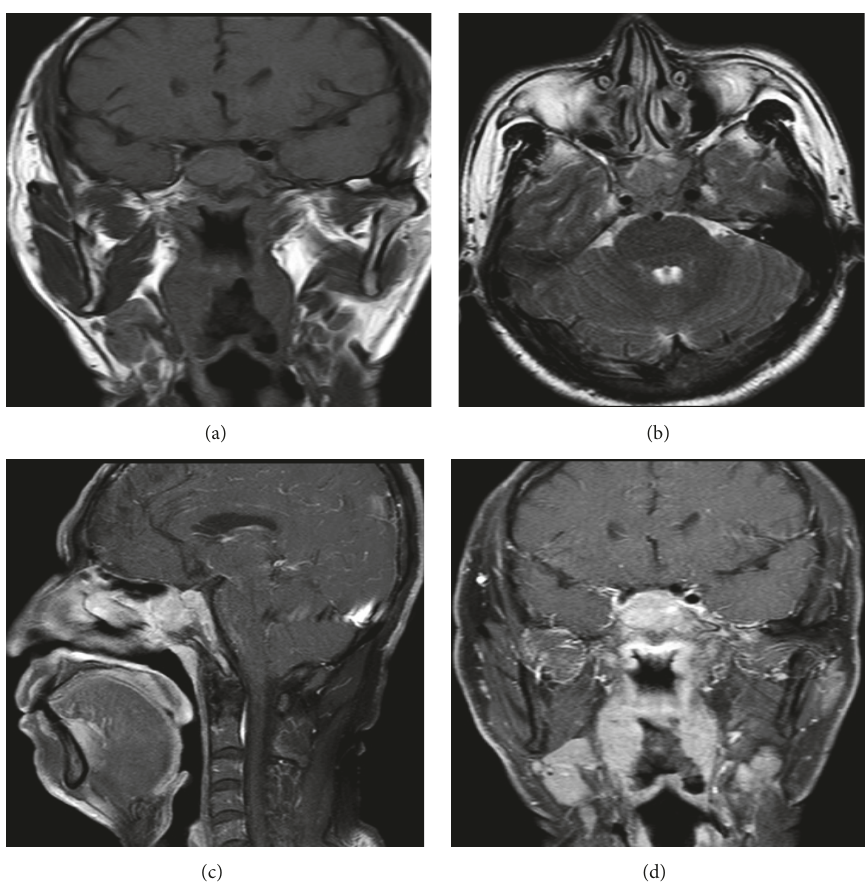
Figure 2: Sagittal T1-weighted magnetic resonance image (MRI) and coronary T2-weighted MRI revealed a mass occupying the sphenoidal sinus (a,b). Gadolinium-enhanced MRI demonstrated the neoplasm with homogenous soft-tissue lesion occupying the sphenoidal sinus and destroying the clivus